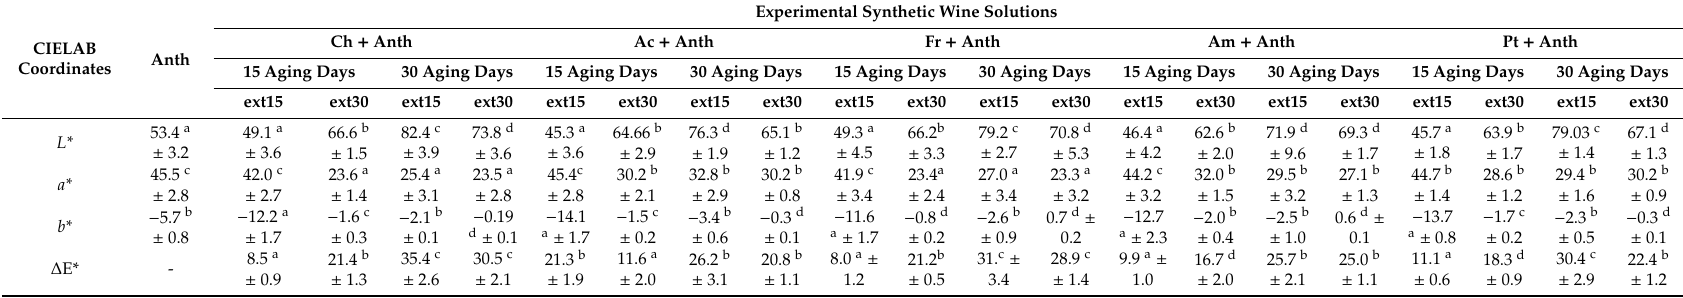
L* (%) (lightness); a* (from green ( − ) to red ( + ) ); b* (from blue ( − ) to yellow ( + ) ); ∆ E* total color di ff erence; the values corresponding to ∆ E* were obtained taking as a reference the anthocyanin extract solution alone. Data points derived for each CIELab coordinate in same line showing the same letter are not significantly di ff erent ( p < 0.05). ± Standard deviation. Average values of four